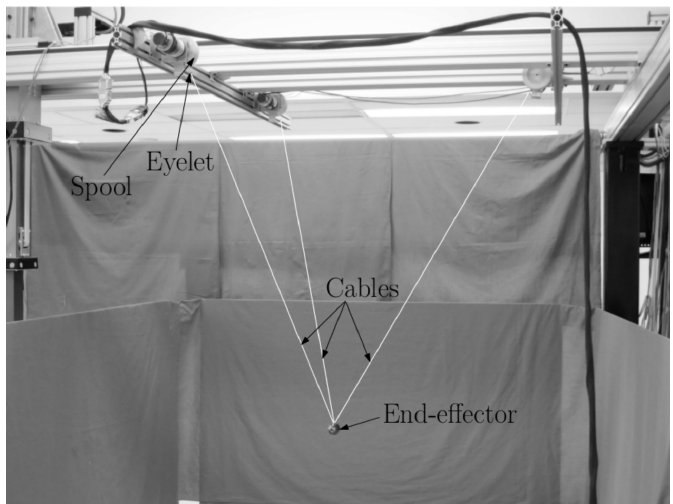
Figure 2. An example 3-DoF, 3-cable spatial CSPR (image taken with permission from